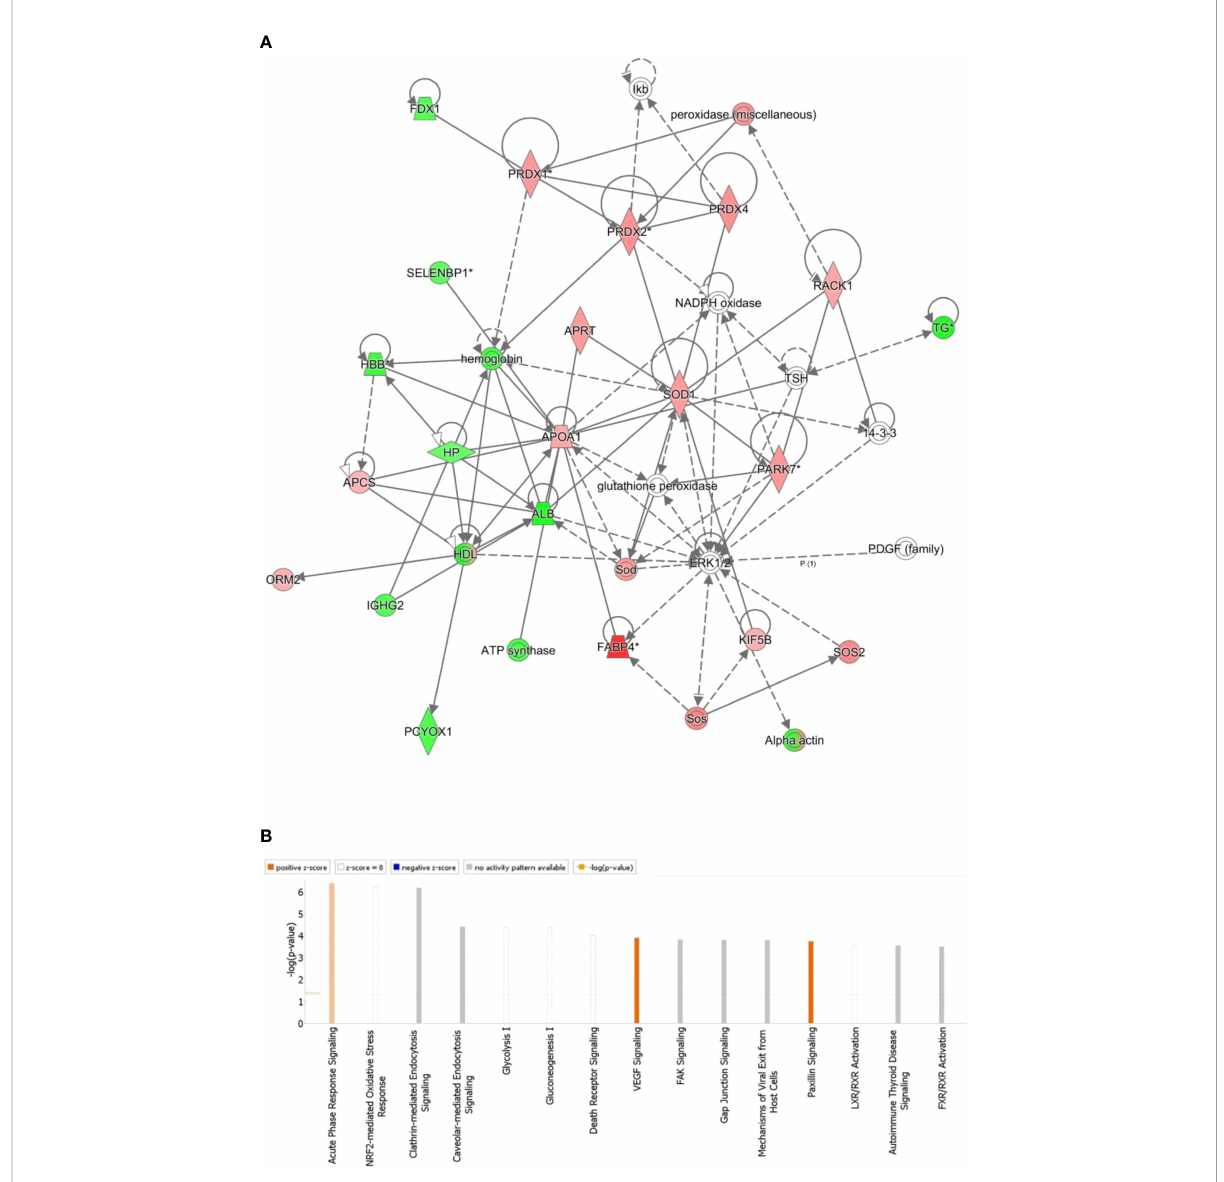
FIGURE 4 The most enriched interaction network of the differentially expressed proteins in BDG compared to the control thyroid states. Red nodes indicate up-regulated; green nodes indicate down-regulated. The central nodes in th the pathway related to signaling of the ERK1/2, Glutathione peroxidase and NADPH oxidase were found to be deregulated between the two groups. Uncolored nodes indicate potential targets that were functionally matched with the differentially expressed proteins. Solid lines indicates direct molecular connections, whereas dashed lines denotes indirect interactions (A) . The fi gure depicts the top 15 canonical pathways as graded by the IPA ’ s P-values (B)